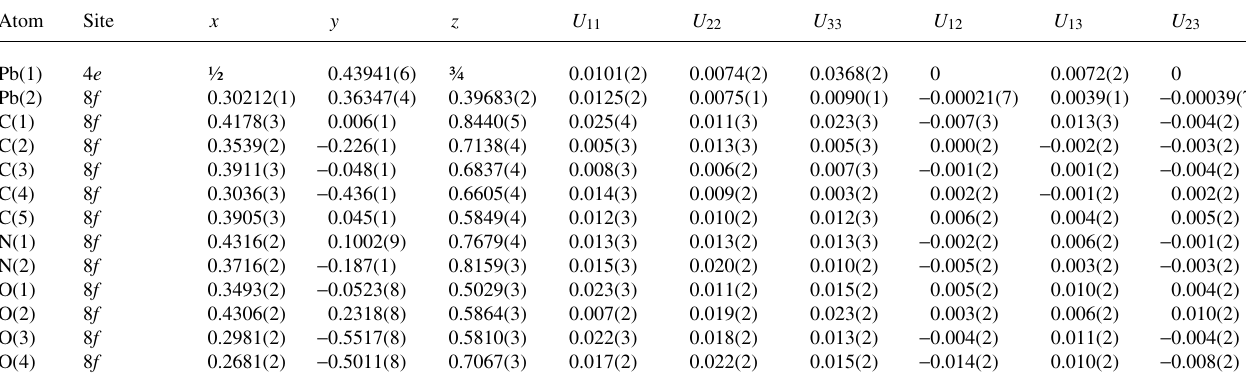
Table 3. Atomic coordinates and displacement parameters (in Å 2 )